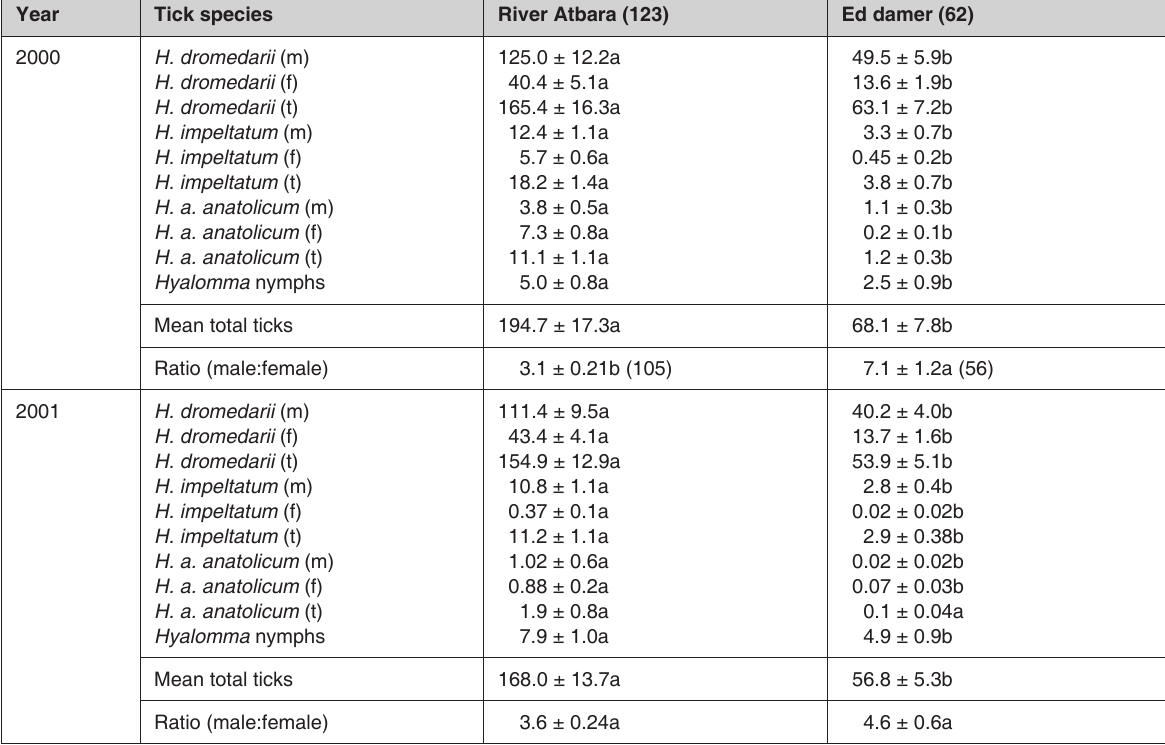
TABLE 1 Means (± SE) of ticks collected from camels along the River Atbara and Ed damer in